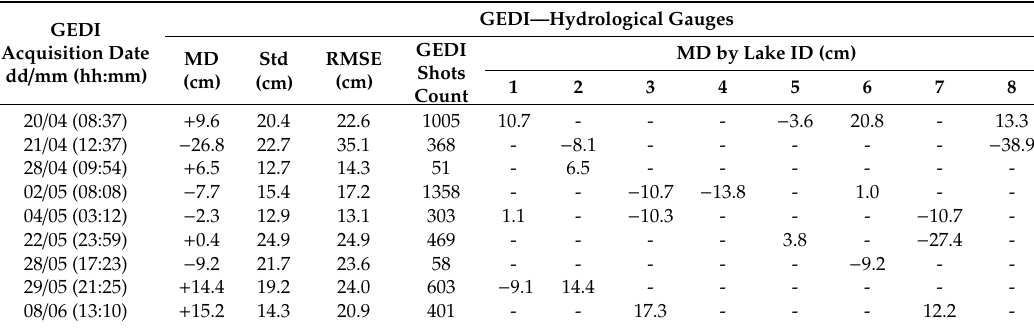
Figure 4. ( a ) GEDI shots across Lake Neuchâtel on May 29, 2019. at 21:25 p.m. ( b ) GEDI elevations of all shots acquired over water plotted for each beam (1 to 8). The reference elevation on this date was 429.53 m (dashed horizontal line). Abscissa = GEDI shot number. Table 4. Summary statistics (mean MD, standard deviation std, and root mean square error RMSE) of the di ff erence between GEDI and in-situ elevations for all the studied lakes (cf. Table 1) aggregated by date (except for May 11th due to the low number of